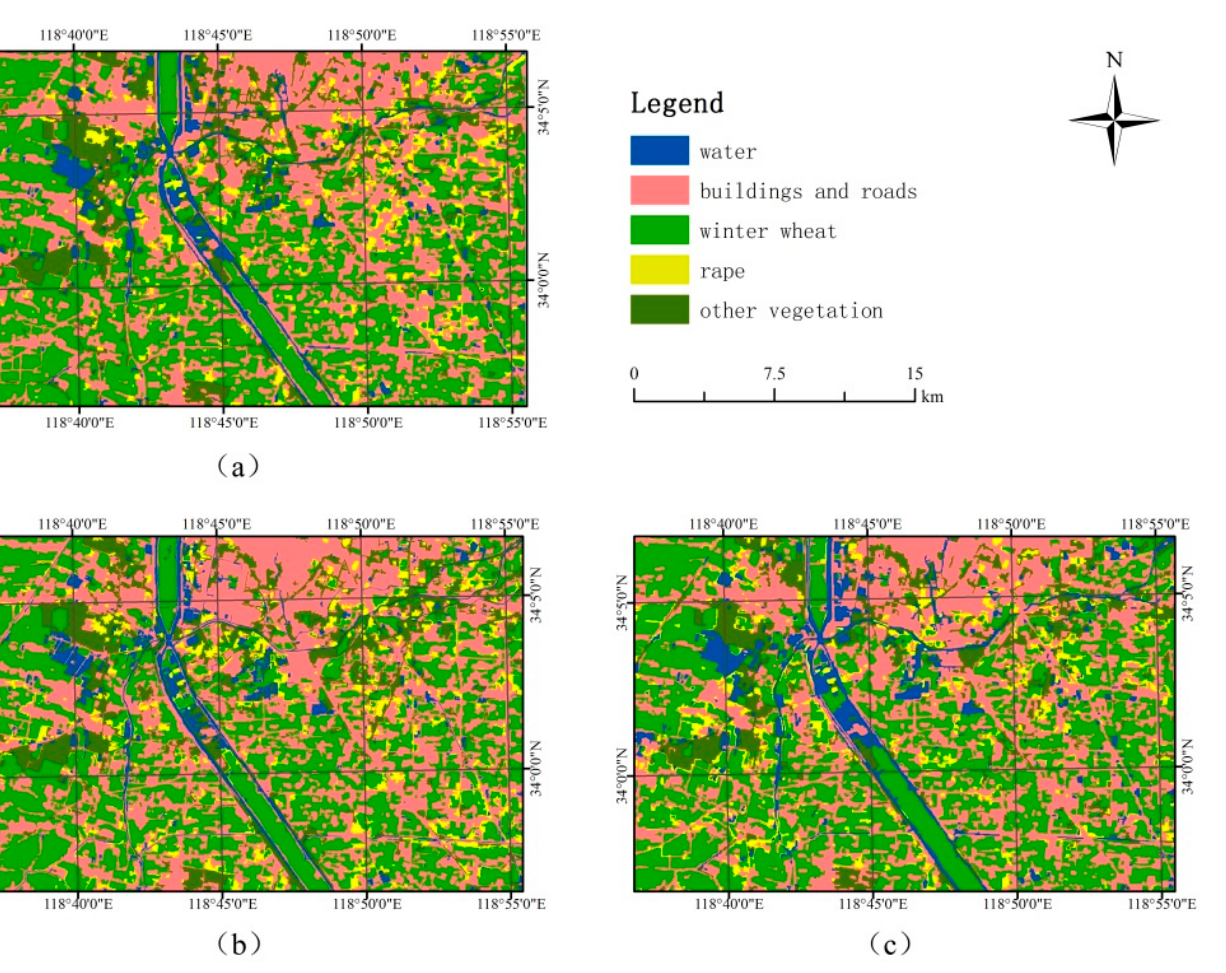
Figure 5. Object-oriented classification results for different combinations of training samples and images. ( a ) classification combination 1, using SFI to classify RI 16m ; ( b ) classification combination 2, using SFI to classify FI 16m ; ( c ) classification combination 3, using SRI to classify RI 16m .